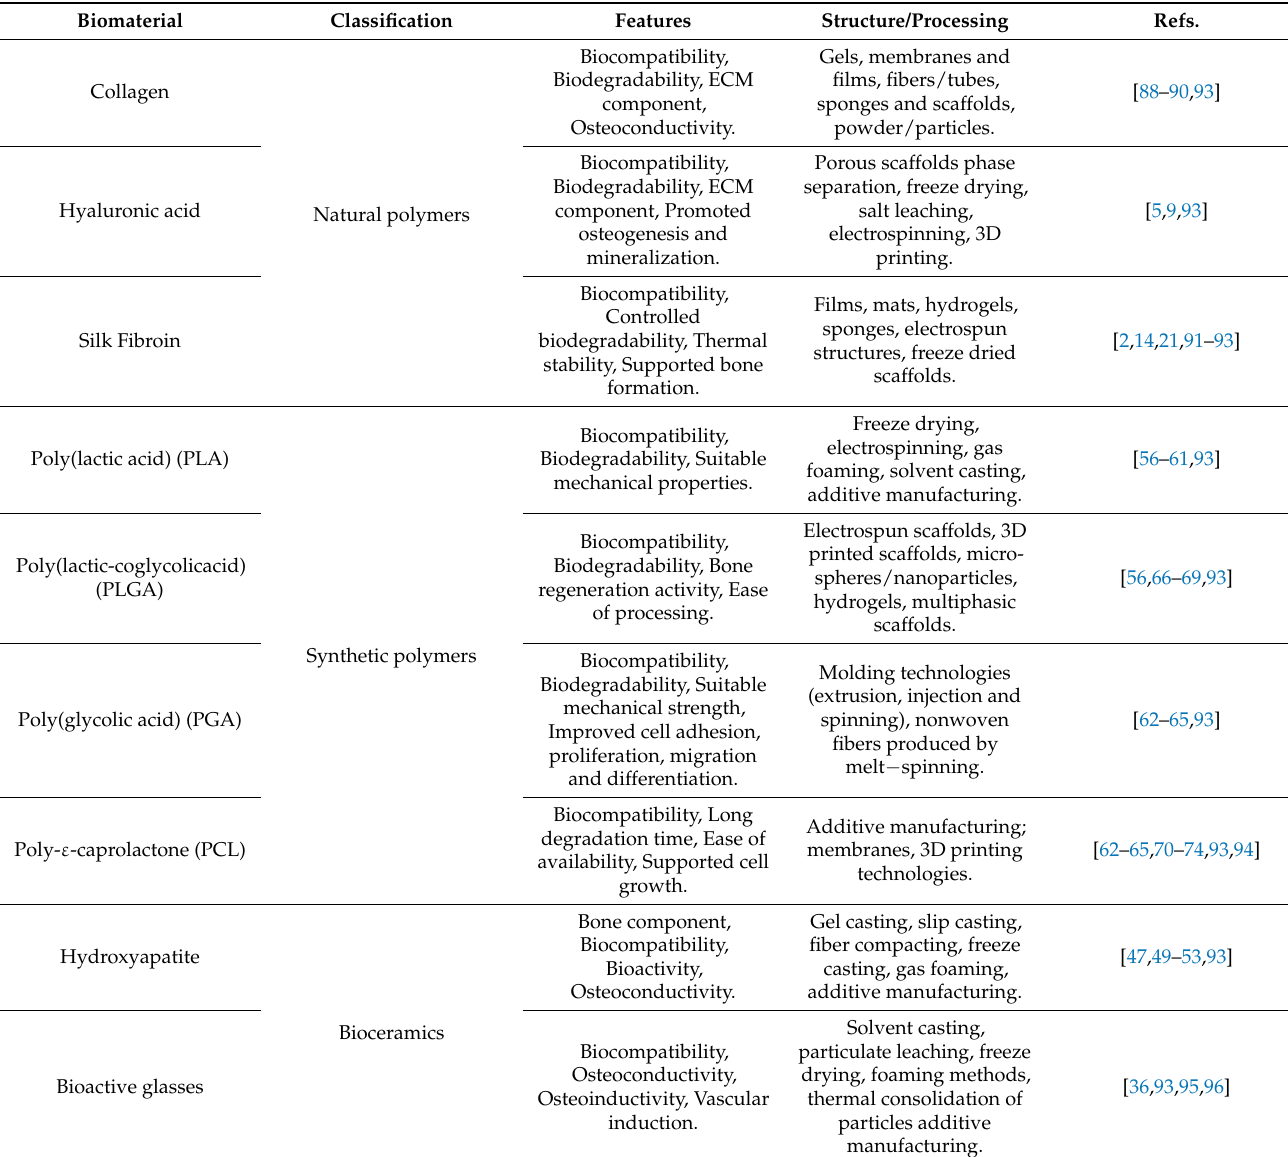
Table 1. Examples of biomaterials for bone tissue